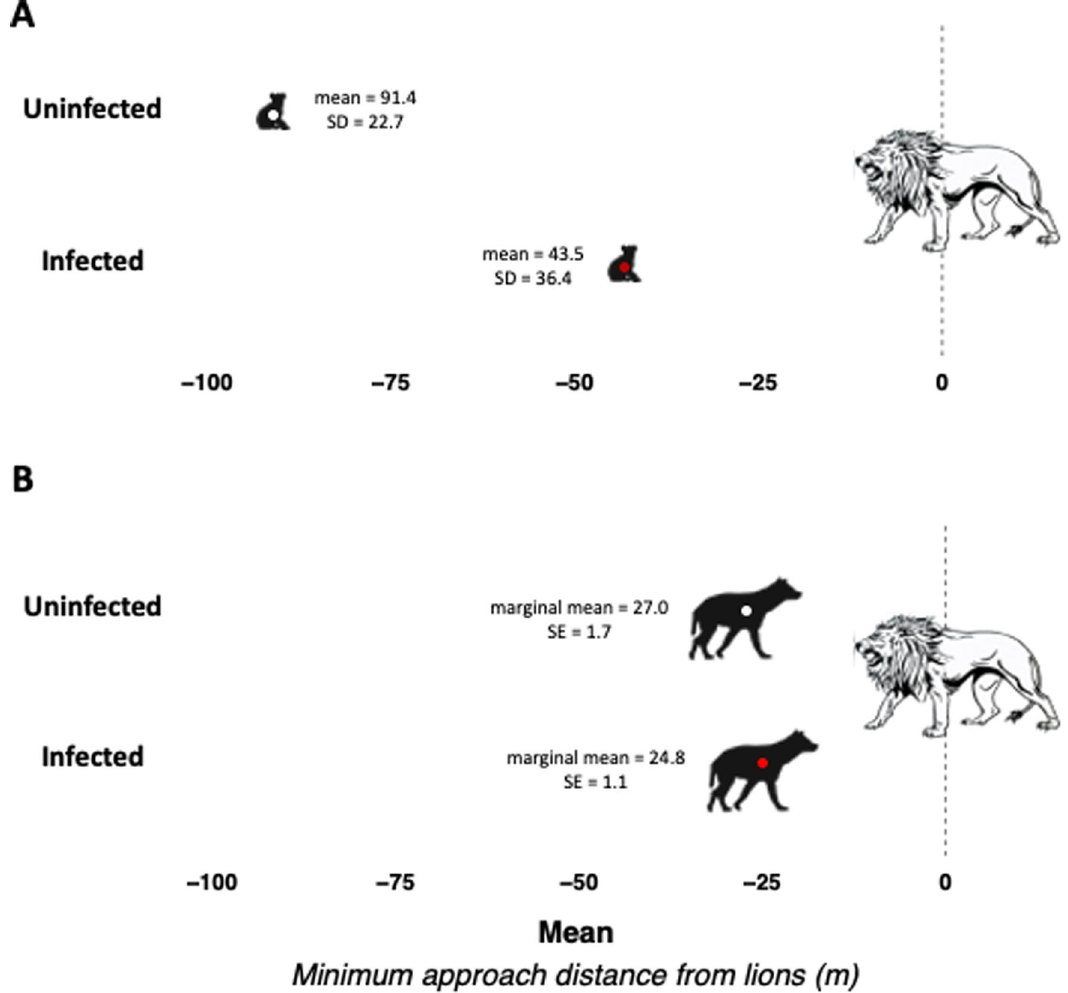
Fig. 1 Mean minimum approach distance to lions for uninfected (white dots) vs. infected (red dots) hyenas. A Among cubs ( N = 15), estimates are raw means and standard deviations based on average minimum approach distance for the uninfected and infected. The cub data set includes only hyenas for which both diagnosis and distance from lions were measured as cubs. B Among subadults/adults ( N = 109), estimates are marginal means and standard errors from a mixed-effects linear regression model that included T. gondii infection status as an explanatory variable, distance as a continuous outcome and a random intercept for hyena ID. Source data are provided as a Source Data fi